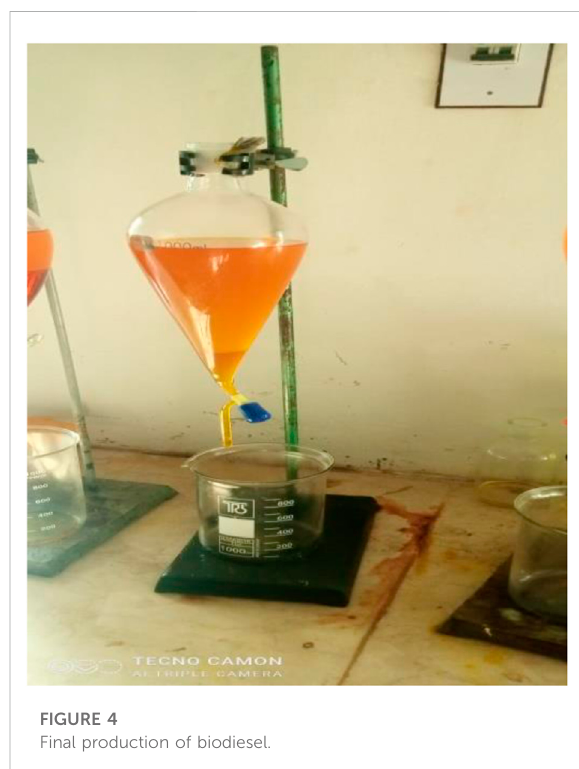
FIGURE 4 Final production of biodiesel.